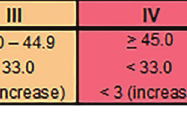
Figure 3. Four progressively worse ventilatory classes. P ET CO 2 : end-tidal CO 2 pressure; VE/VCO 2 : ventilation to carbon dioxide production relationship. Adapted from reference